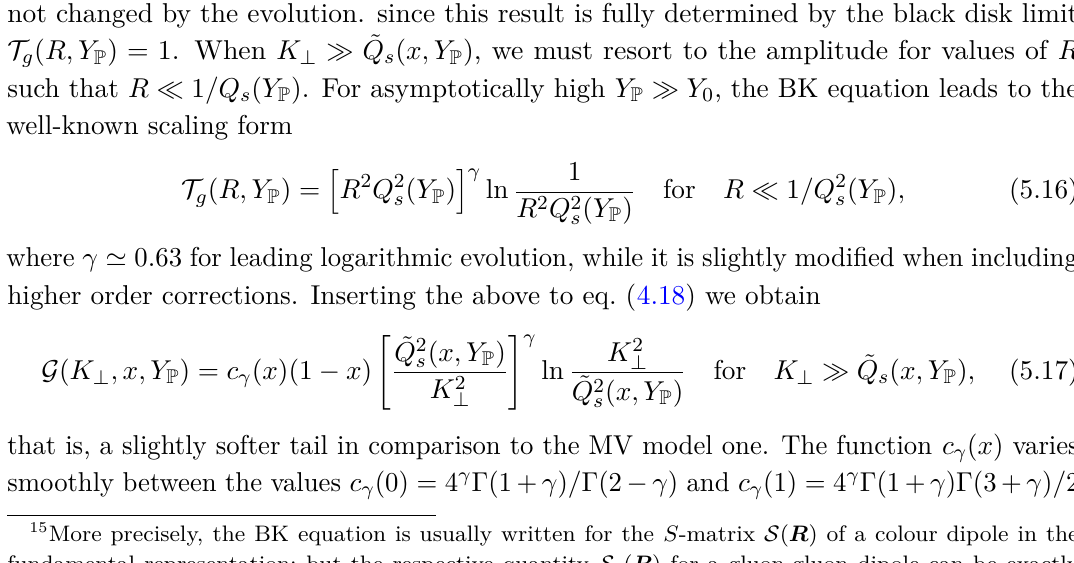
) , for various values of P ) is obtained from P = 0 (i.e. Y = Y 0 ) given by the P P